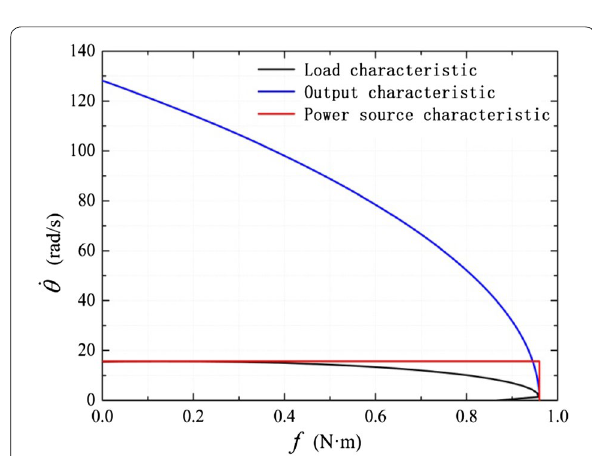
Figure 8 Power source characteristic